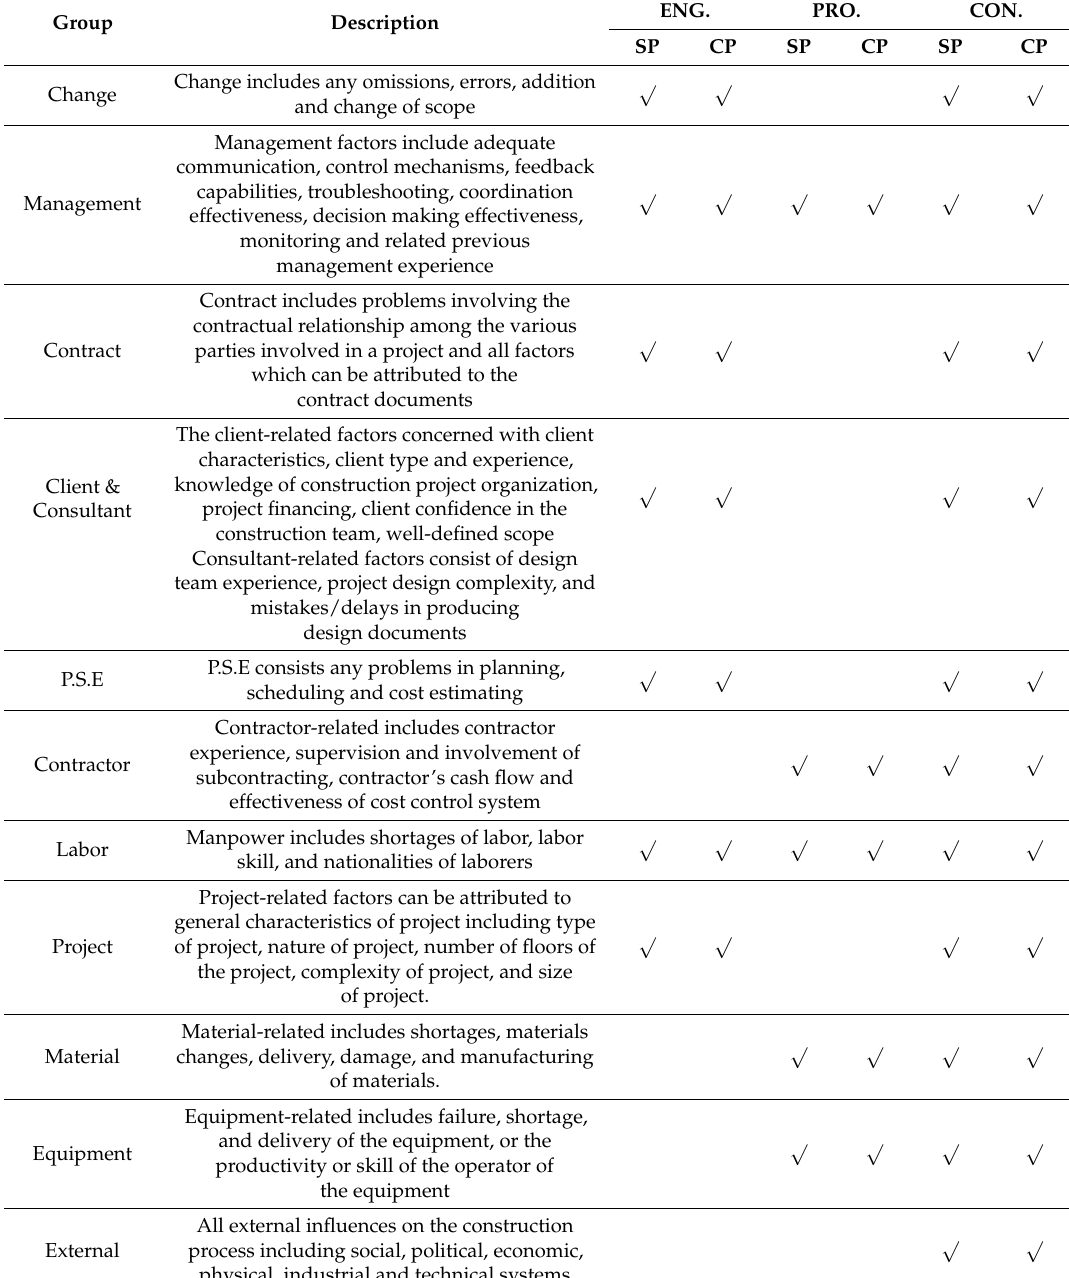
Table 2. Classification of Performance Indicators and Their